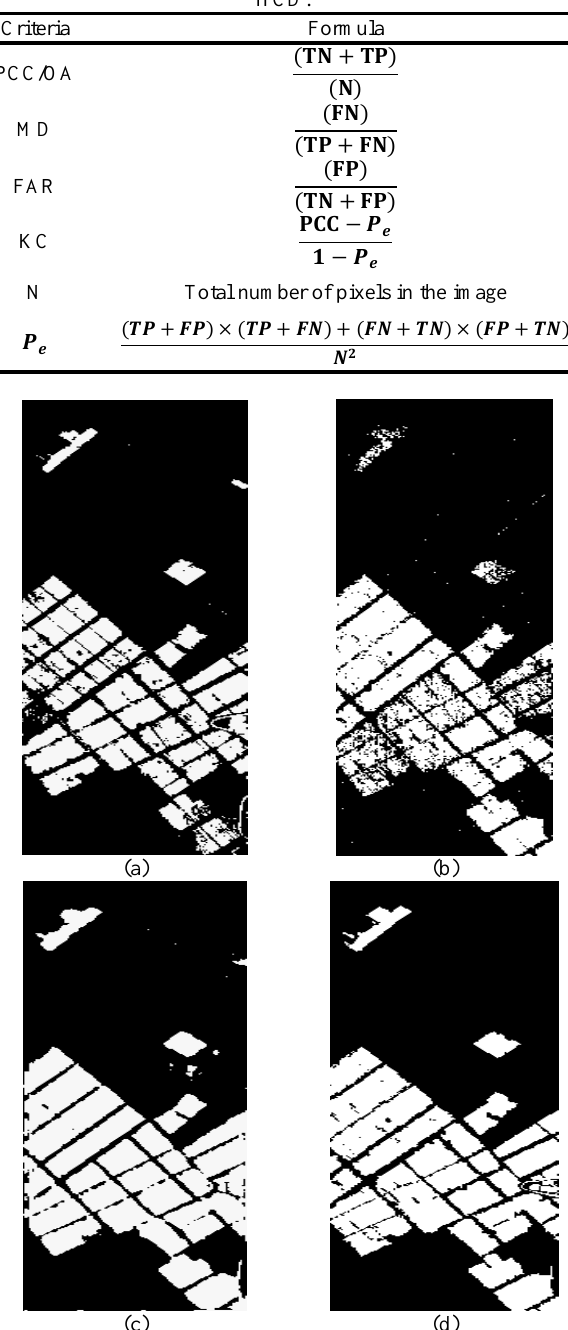
Fig. 4. The results of HCD methods for the USA dataset. The (a) MAD-SVM, (b) IR-MAD-SVM, (c) proposed method, and (d) Ground